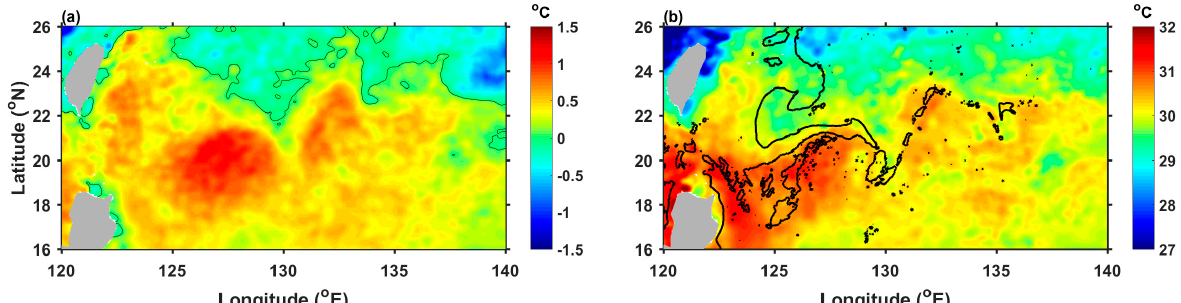
Figure 7. Spatial distribution of ( a ) monthly SST anomalies in July 2010 referring to the month climatology from 1998 to 2020, and ( b ) daily SST on 12 July 2010, based on the OISST product gridded at 0.05°. Thin curve in ( a ) show the zero contour of SST anomalies. Bold curve in ( b ) shows the Chl-a contour at 0.07 mg m − 3 , representing the high Chl-a filament.